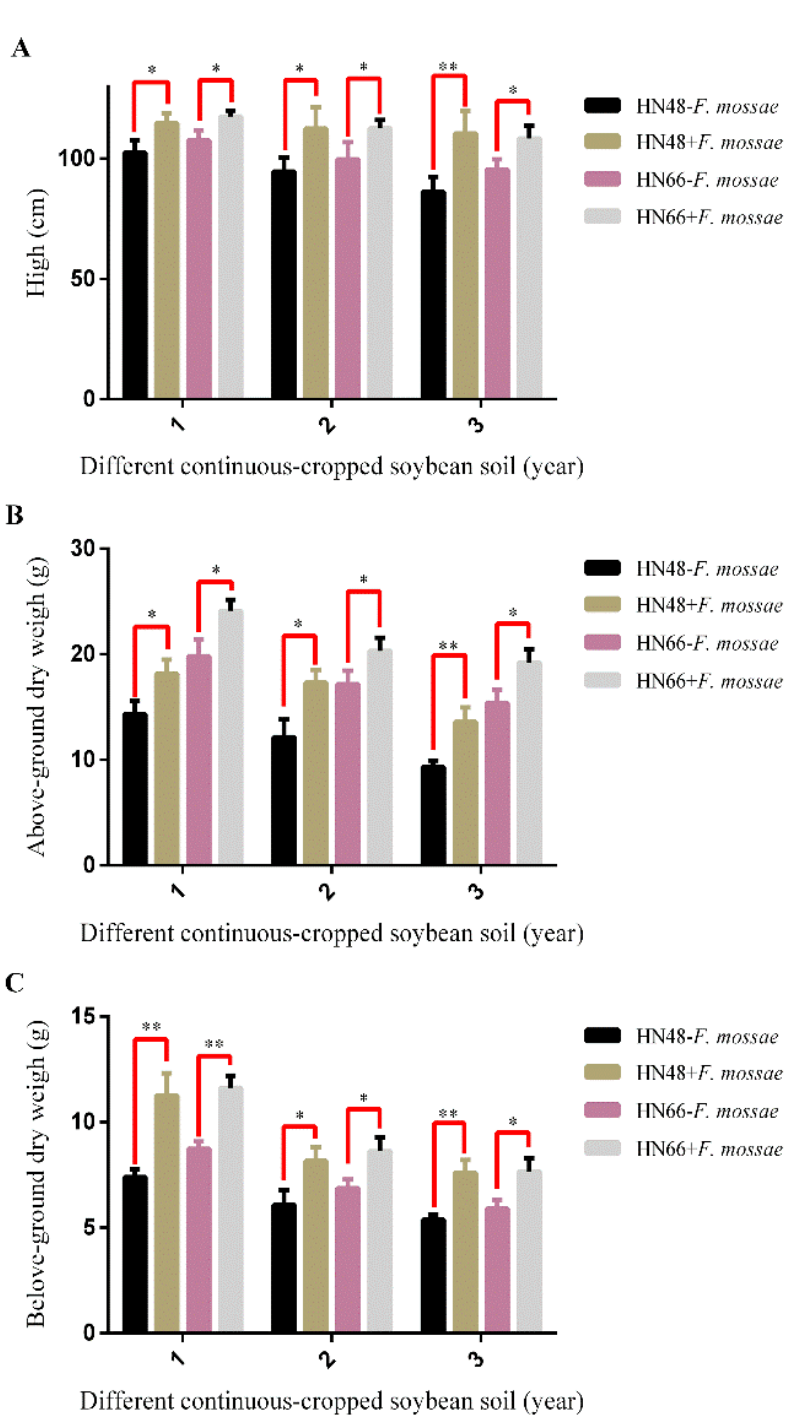
Figure 3. The biomass of two soybean cultivars under different continuous-cropped year soil in potted-experiments of soybean: 1 means soybean were planted the normal soil; 2 means soybean were planted in one-year continuous cropping soybean soil; and 3 means soybean were planted in three-year continuous cropping soybean soil. Each value represents the average of six independent experiments and the error bars represent standard deviations. Asterisks indicate the significance of differences between the samples. p values were calculated by Student’s t -test. Single asterisk indicates p < 0.05; double asterisks indicate p < 0.01.